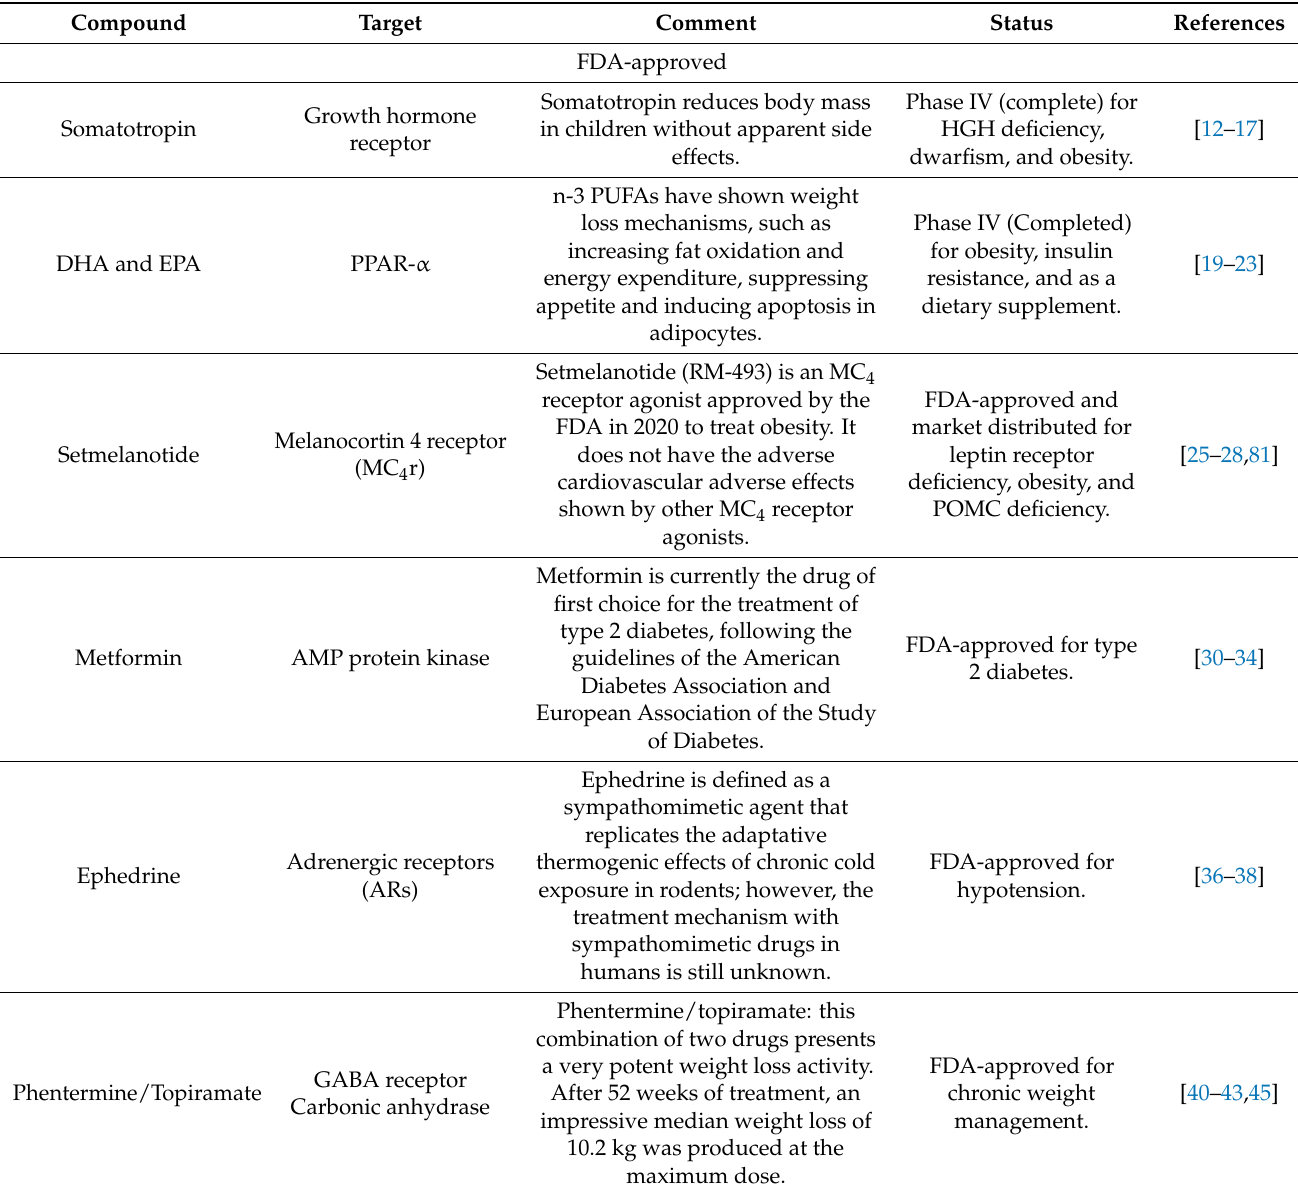
Table 1 summaries all drugs revised herein. Table 1. Drugs Targeting Energy Expenditure for